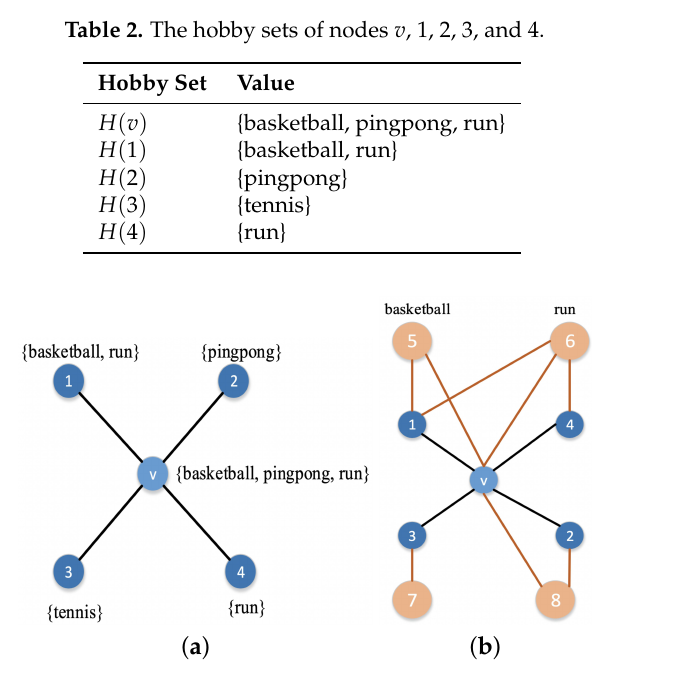
Figure 1. Hobby sets and the network of nodes’ similarity. ( a ) A network of nodes with hobby sets. ( b ) Each hobby set of one node is treated as a set of neighbor